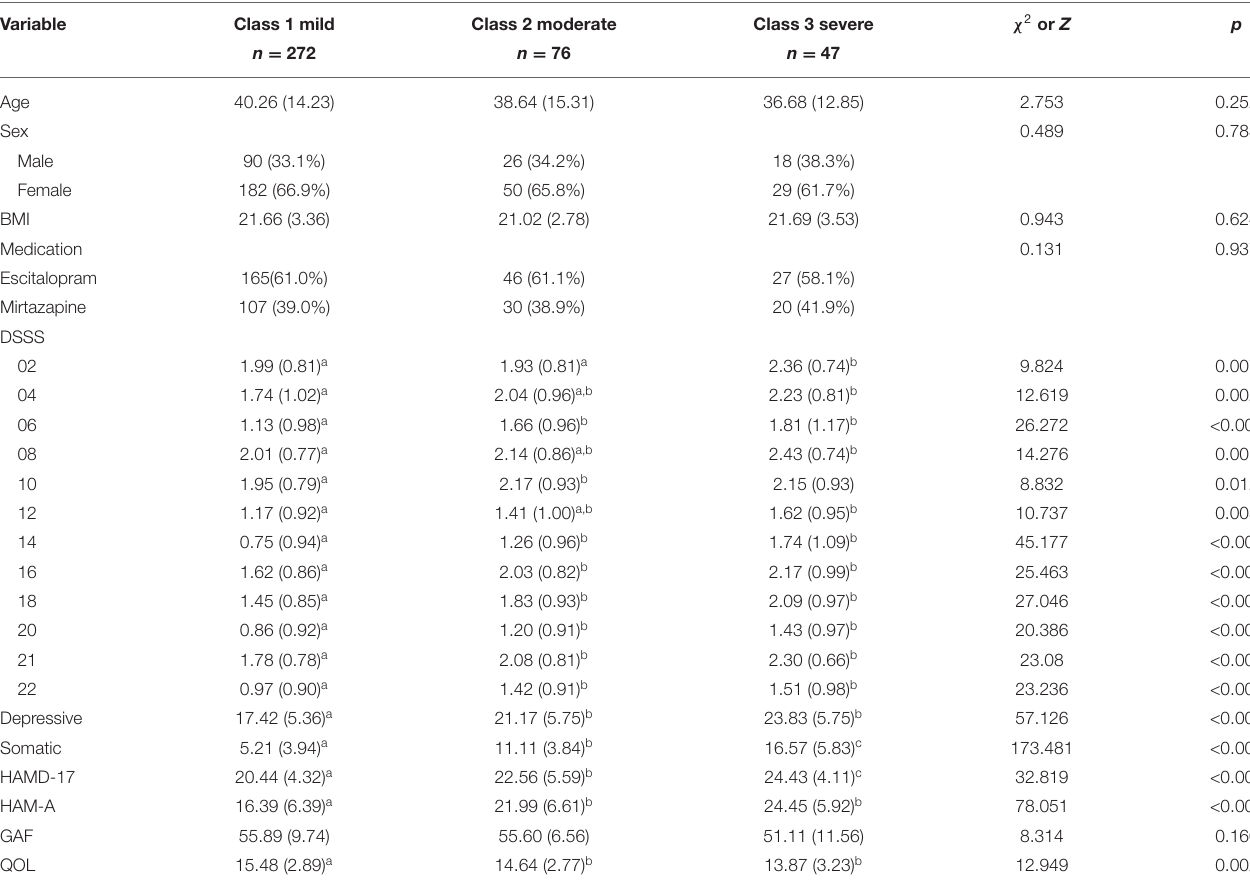
TABLE 3 | Comparison of demographic and clinical characteristics across the three subtypes.